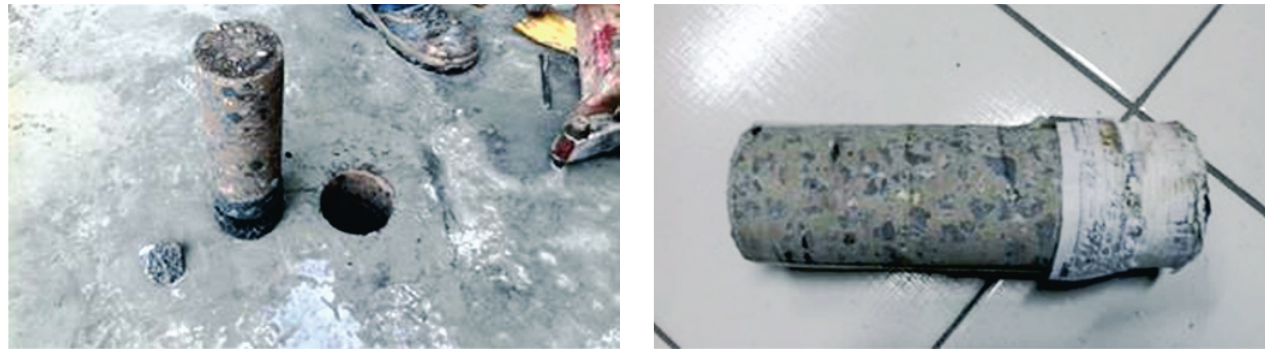
Forensic extraction of CRCP slab